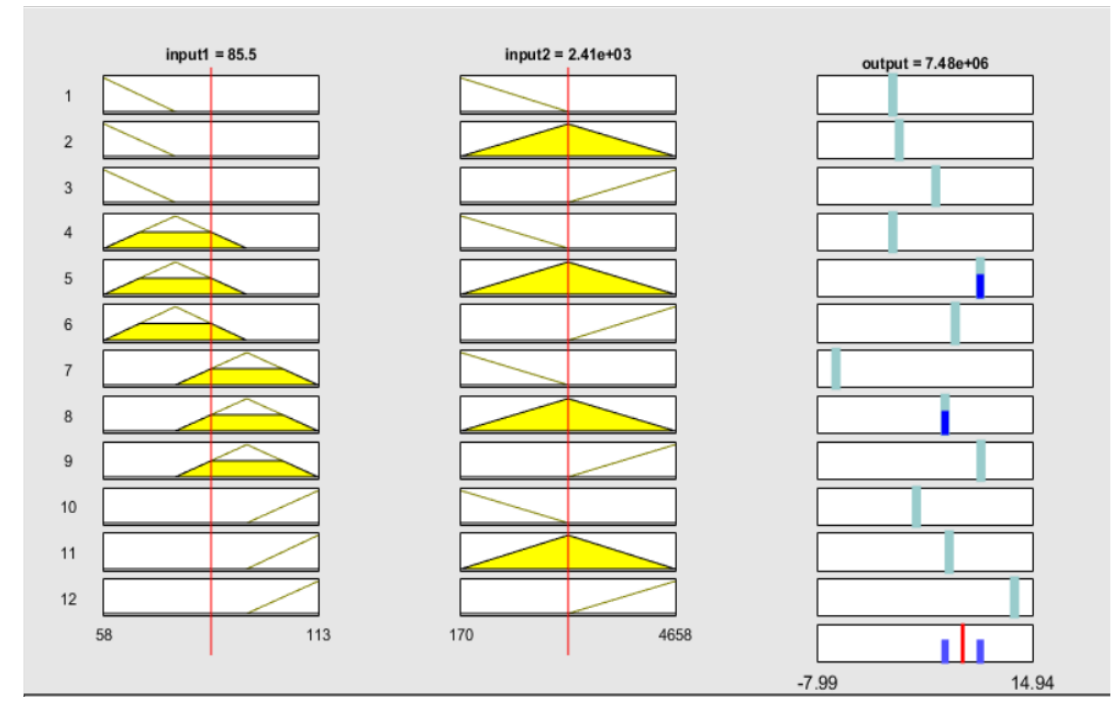
Figure 16. ANFIS-GA model testing.